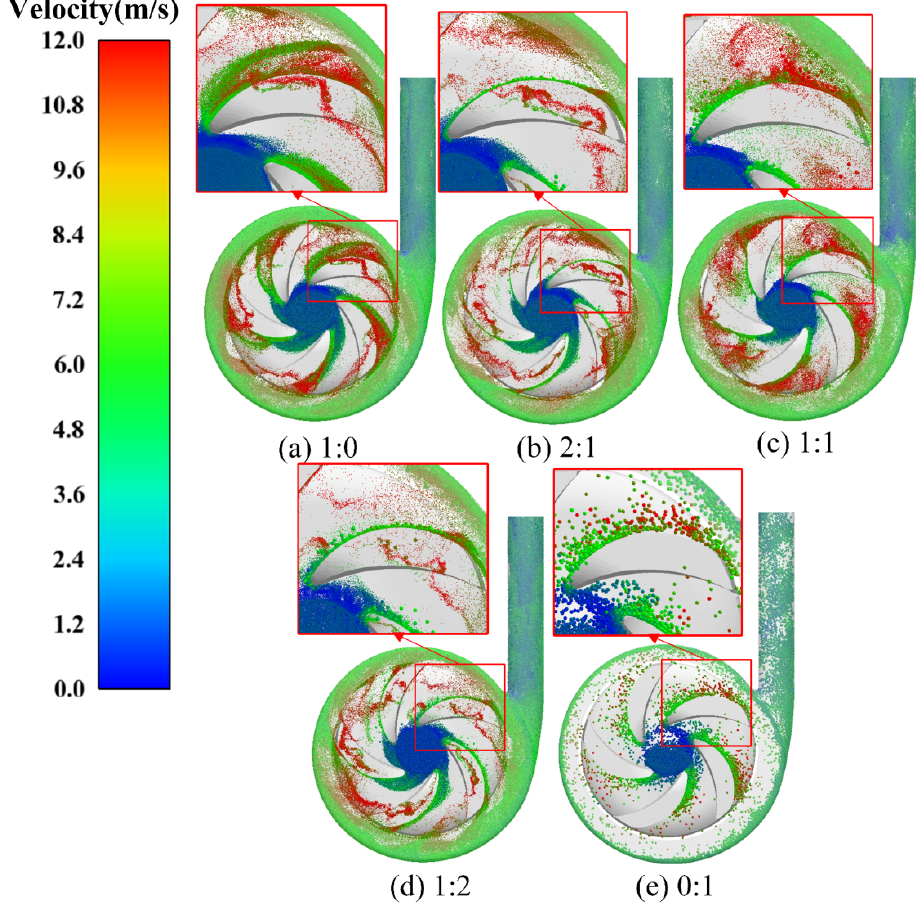
Figure 11. Particle distribution in centrifugal pump with different particle ratios.